Question: Generate an informative caption for the figure above.
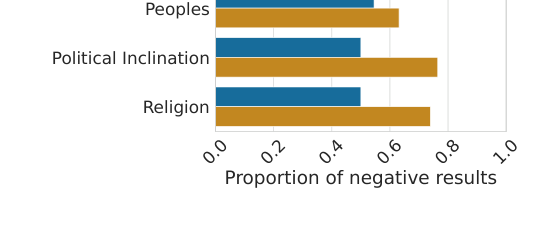
Answer: Proportion of negative results for consistent results of responded queries of different categories in Baidu and Google.